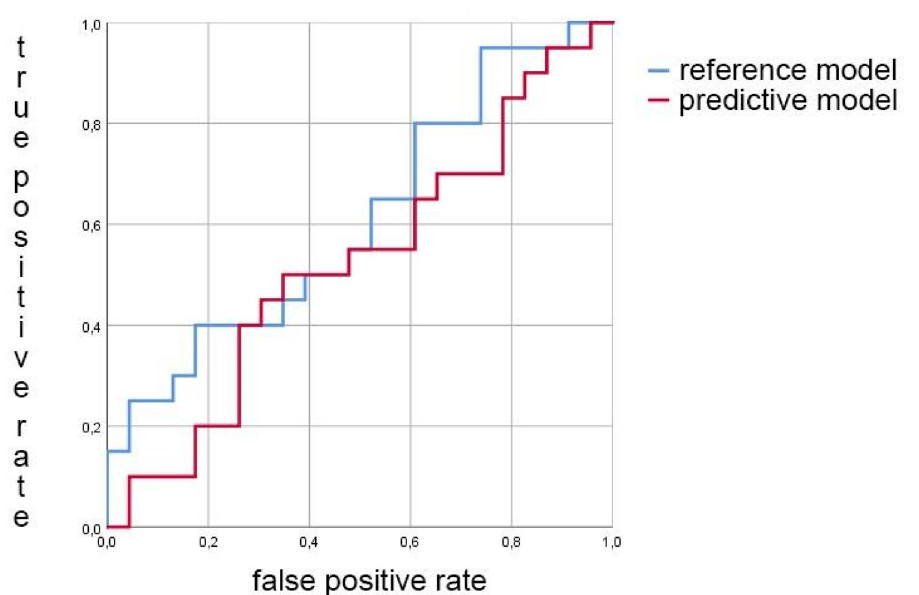
Figure 3. The receiver-operator curves (ROCs) for the predictive model (red) using selected AE signals, KI, age and BMI, and for the reference model (blue) using age and BMI in males. No significant statistical difference was found using DeLong method ( p =